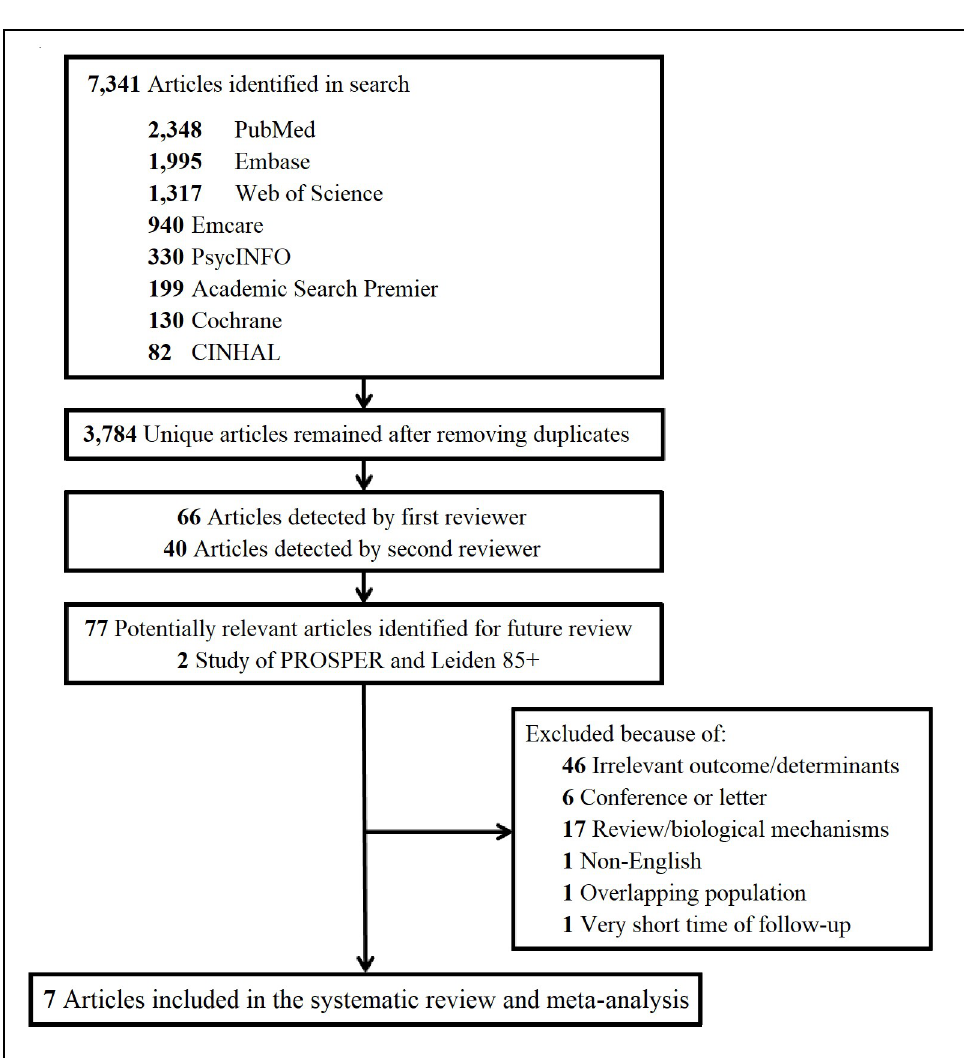
Fig 1. The literature search for the systematic